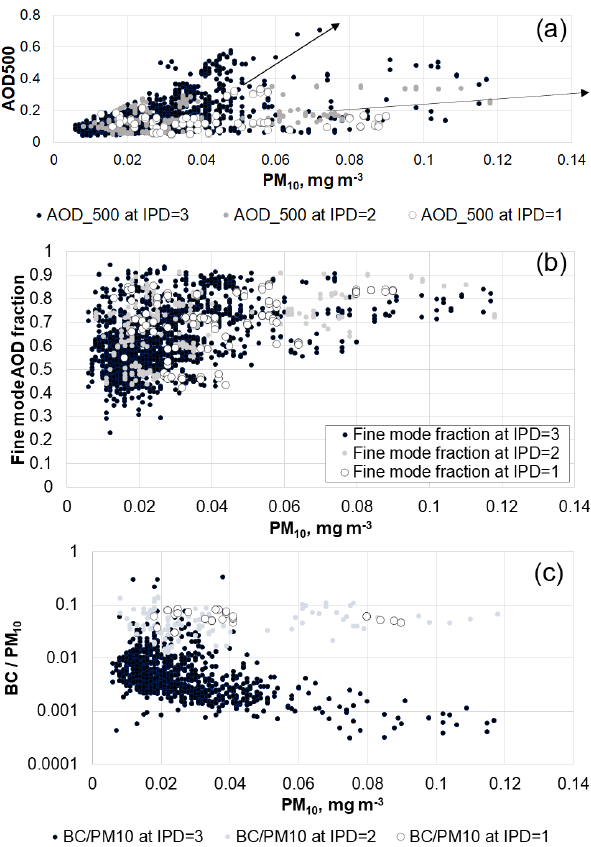
Figure 5. AOD at 500nm (a) , fine-mode fraction of AOD at 500nm (b) , and BC / PM 10 ratio (c) as a function of PM 10 mass concentration (mgm − 3 ) under various IPD mixing air